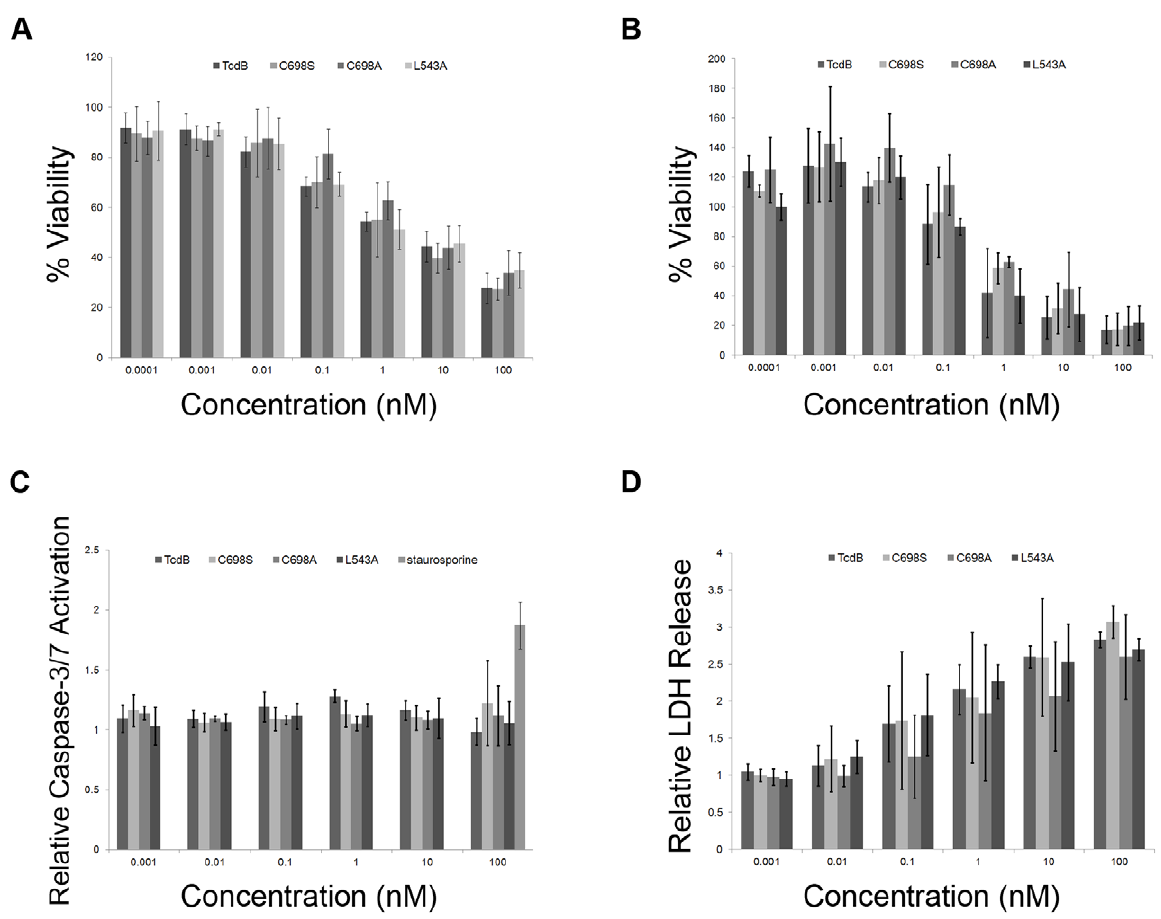
Figure 3. Autoprocessing mutants induce necrosis in epithelial cells. A , Toxins were applied to HeLa cells at concentrations ranging from 0.1 pM to 100 nM, and viability was measured after 2.5 hours with CellTiterGlo. B , Toxins were applied to Caco2 cells at concentrations ranging from 0.1 pM to 100 nM, and viability was measured after 18 hours with CellTiterGlo. Percent viability was determined by normalizing the signal from treated cells to the signal from untreated cells. C , Autoprocessing mutants did not induce caspase-3/7 activation after 25 hours. D , Comparable levels of extracellular LDH were detected after 8 hours in HeLa cells treated with wild-type TcdB and TcdB autoprocessing mutants. In each panel, the values represent the average of three experiments in which three replicates were averaged. Error bars indicate the standard deviation between the values obtained from the three experiments.